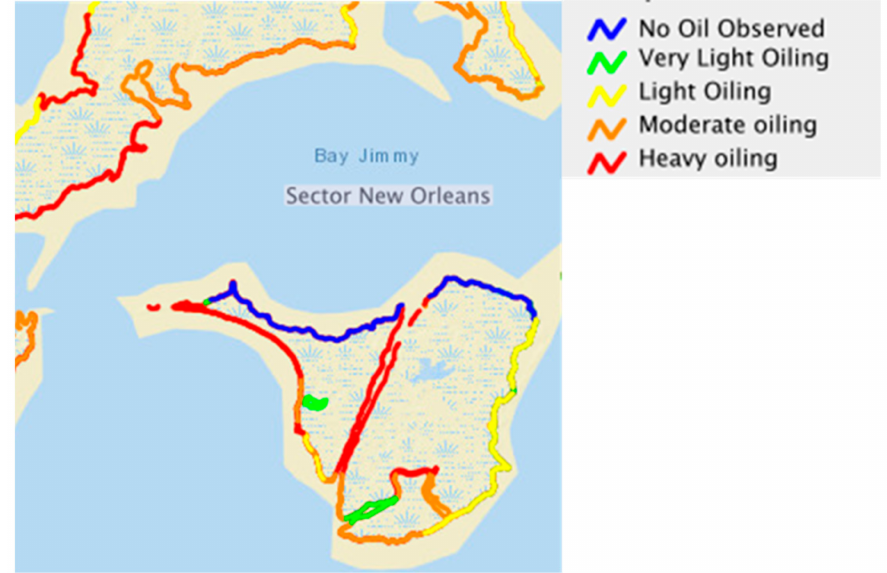
Figure 13. Environmental Response Management Application (ERMA), 17 September 2010—SCAT (Shoreline Cleanup and Assessment Technique) oiling ground observations